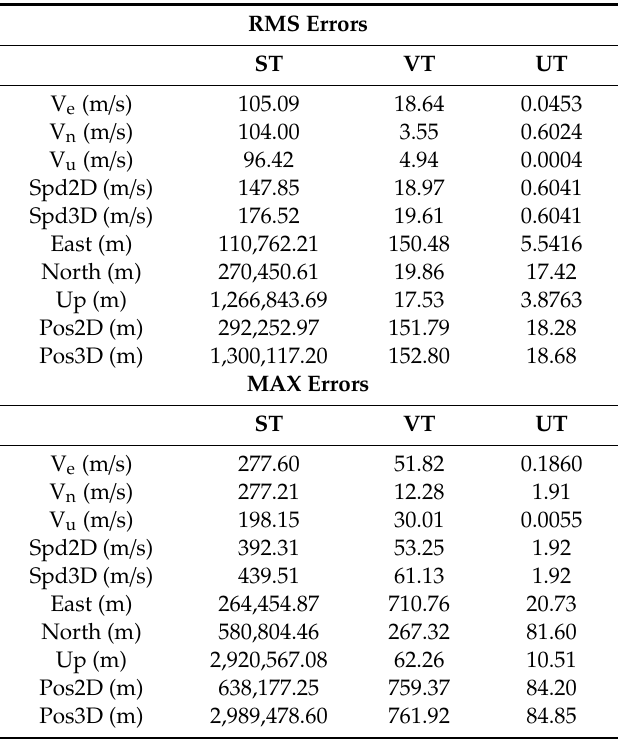
Table 2. Summary of position and velocity